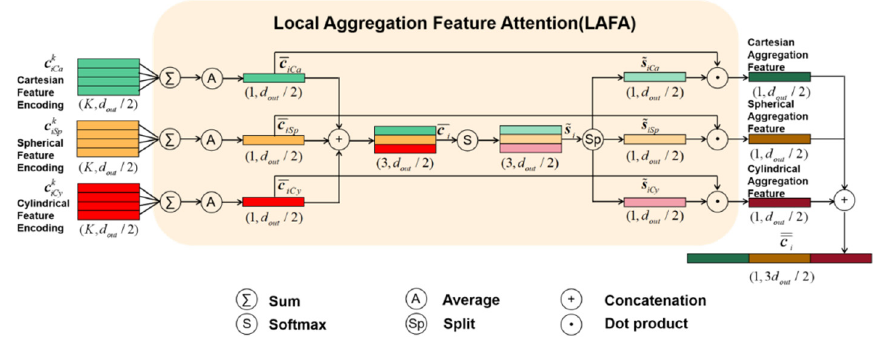
Figure 7. The architecture of LAFA block.